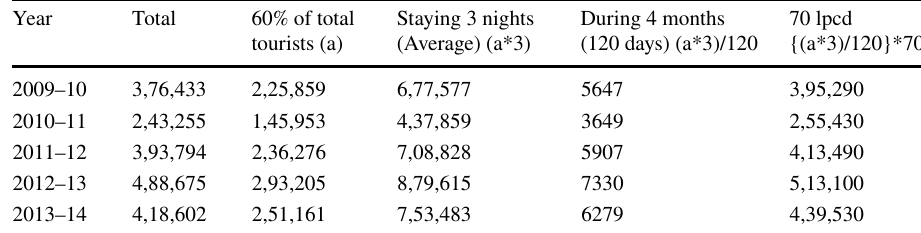
tourists during peak-season